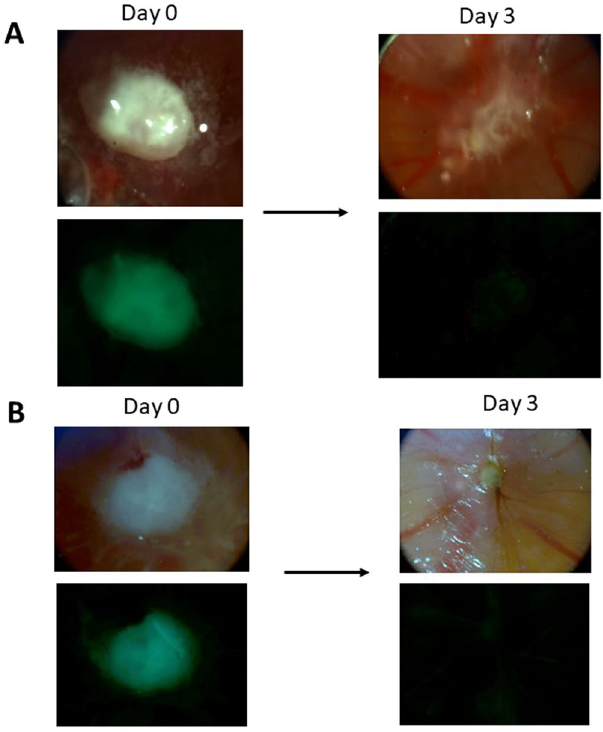
Figure 4. Intravenous injection of biodegradable PMO loaded with doxorubicin results in the elimination of Ov8GFP tumor. PMO-1 ( A ) or PMO-2 ( B ) loaded with doxorubicin was injected intravenously and the effect on tumor was examined by bright field and green